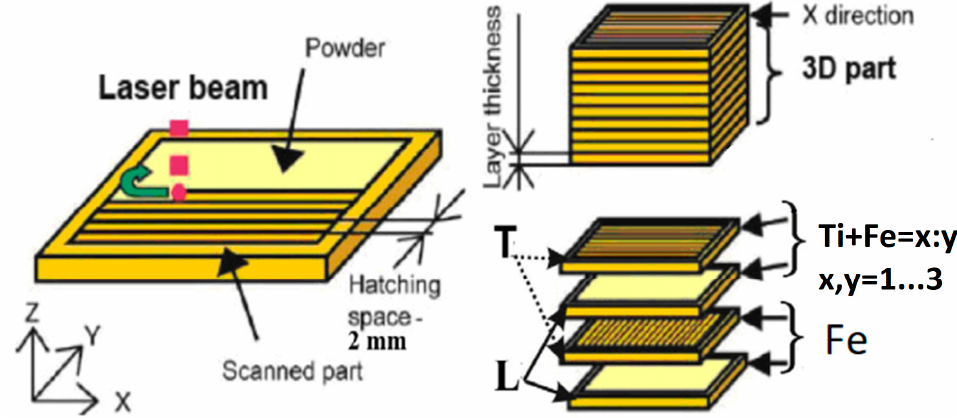
Figure 1. Schematic of the multi component graded structure fabrication by DED. Longitudinal—L; transversal—T [10,24–26].